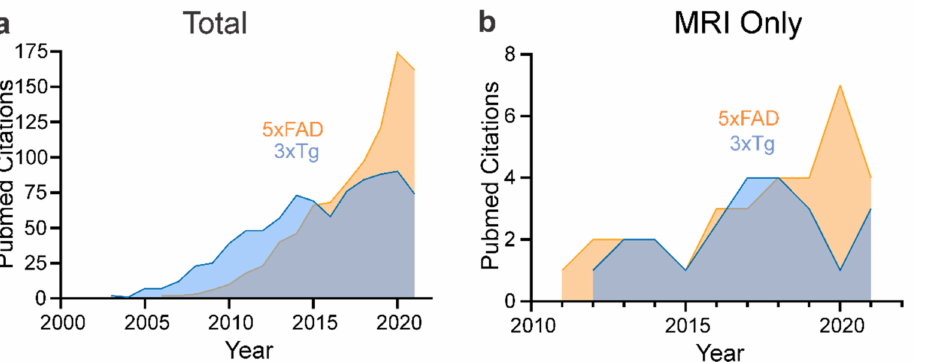
Figure 1. Pubmed citations for 5xFAD and 3xTg-AD mouse models. ( a ) The total number of Pubmed citations for the two most popular AD mouse models, illustrates the rapid rise in reports utilizing